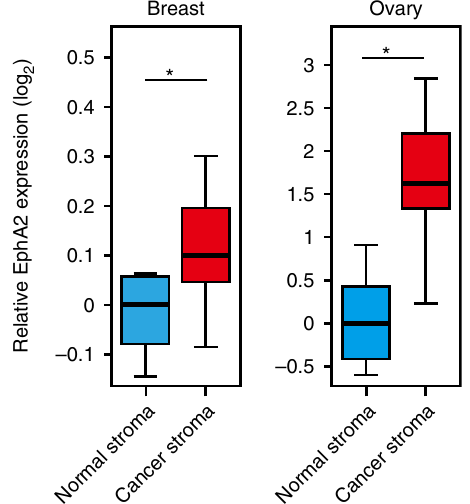
Figure 9 | EphA2 expression is increased in the stroma of breast and ovarian cancers. The left boxplot shows EphA2 mRNA expression levels in normal breast stroma ( n ¼ 6) and breast cancer stroma ( n ¼ 26). The right boxplot shows EphA2 mRNA expression levels in normal ovarian